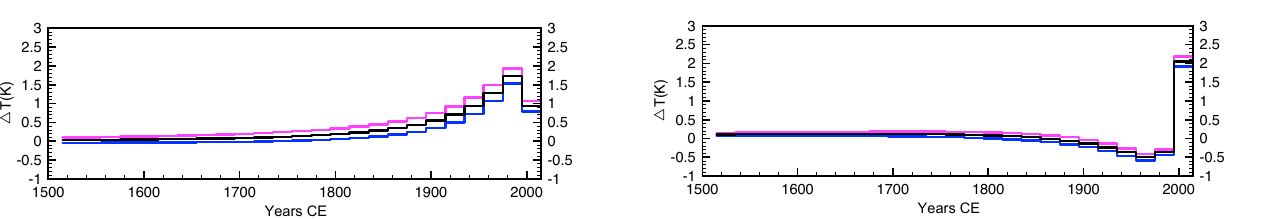
Figure 9. GST history for north-central Chile determined by the si- multaneous inversion of DDH2457, 1501, 1504, 1505, RC370, and ala1110-2, with three eigenvalues retained. The pink and blue lines represent the inversion of the upper and lower bounds of the tem- perature anomaly or the extremal steady